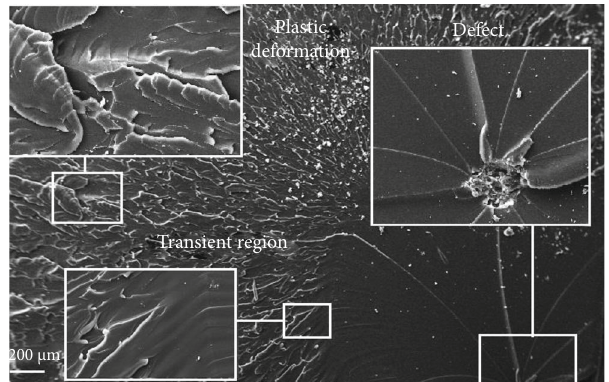
Figure 6: Micrograph image of epoxy sample fractured at 25 ° C creep test.